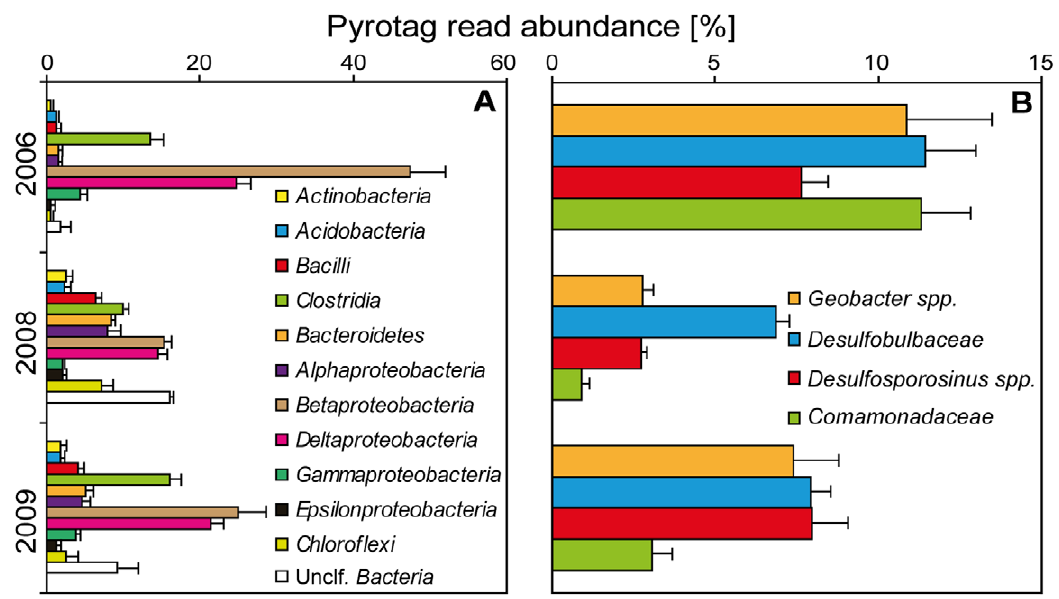
Figure 1. Reproducibility of pyrotag read abundance over biological replicates of aquifer DNA extracts. Error bars indicate standard deviation (positive only) of averaged triplicate samples for each year. Taxon classification was recorded at phylum/class level (A) for entire libraries, and for selected abundant taxa (B) detected at the site [11,13].